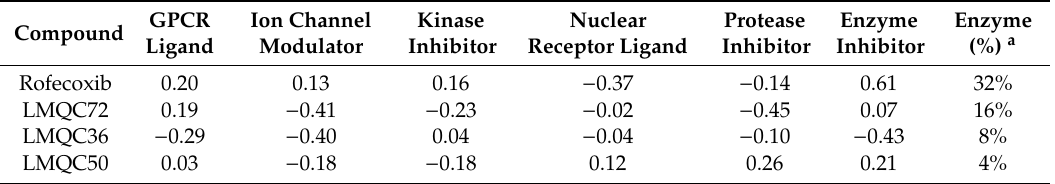
Table 6. Prediction of bioactivity of the selected compounds.